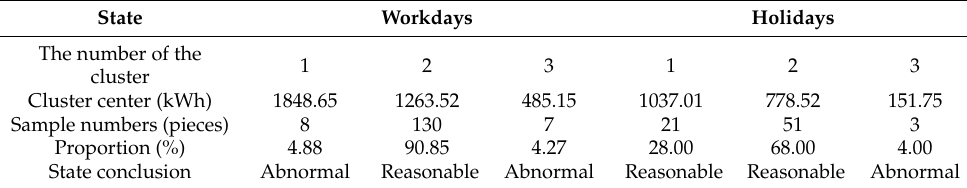
Table 3. K-means clustering results of daily lighting socket